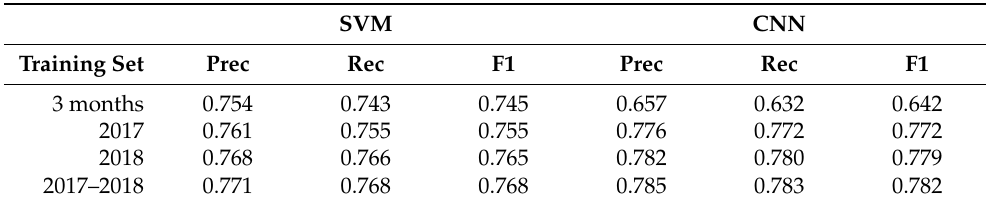
Table 3. Test set precision, recall and F1 (weighted average) of SVM and CNN models with different training sets. SVM CNN Training Set Prec Rec F1 Prec Rec F1 3 months